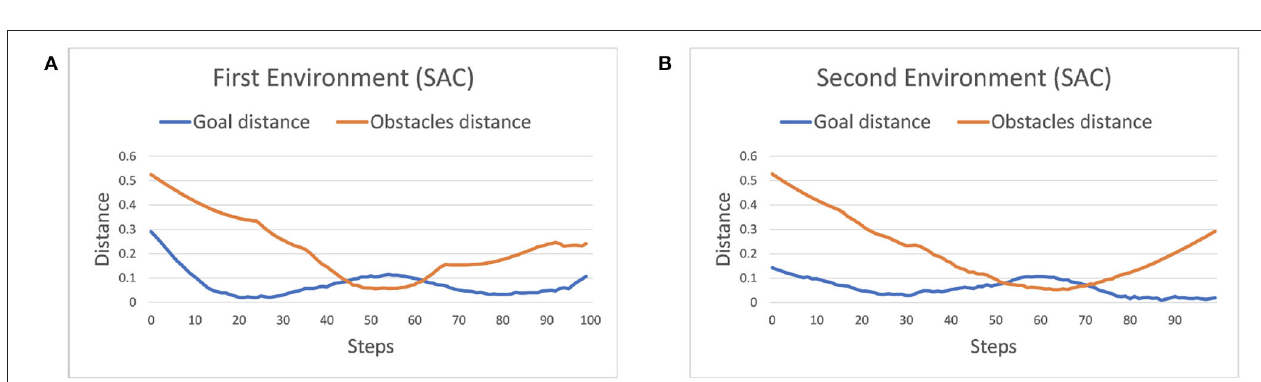
FIGURE 5 | The behavior of the manipulator with respect to the distance(m) in one of the episodes (100-time steps). (A) Distance between robot and obstacles as well as the target (first scenario). (B) Distance between robot and obstacles as well as the target (second scenario).